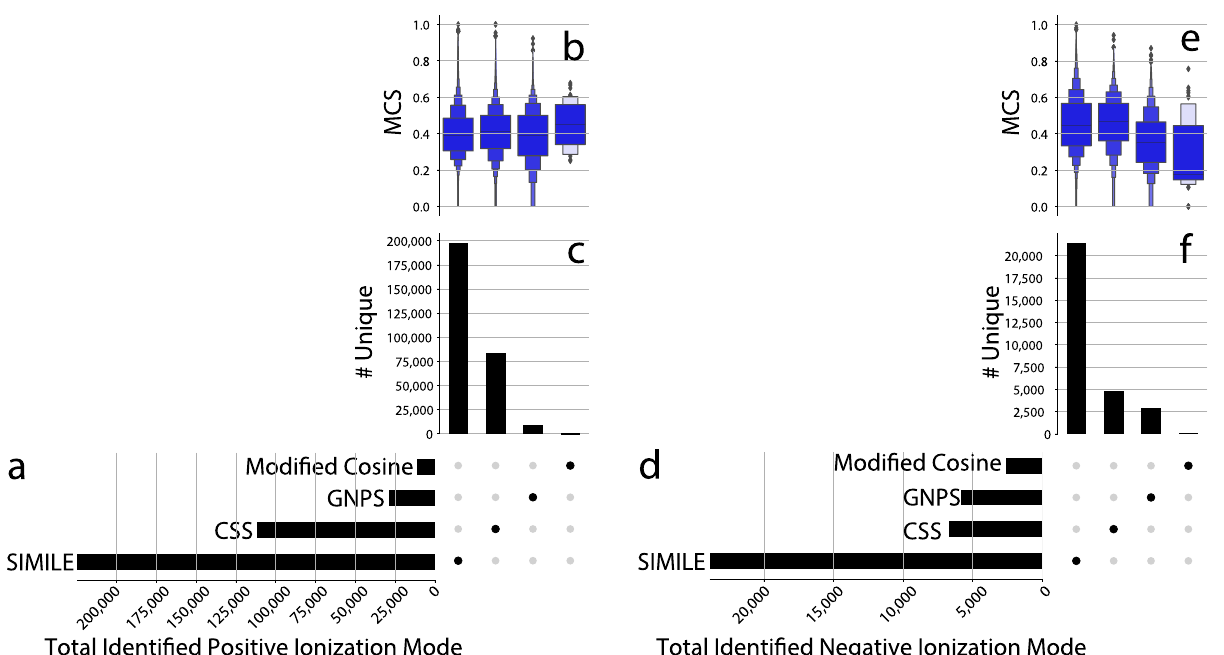
Fig. 4 SIMILE identi fi es the largest number of similar pairs and 88% and 89% of the pairs of spectra identi fi ed by SIMILE in positive and negative ionization mode were not found by any other algorithm. Pairs of spectra identi fi ed by each algorithm for positive ( a – c ) and negative ( d – f ) ionization modes can be seen in these UpSet plots. The total number of pairs identi fi ed by each algorithm is shown in the bar chart to the left ( a and d ), and the unique pairs identi fi ed by each algorithm along with their corresponding structural similarity are shown in ( b , c ) and ( e , f ). Boxen plots ( b , e ) show several quantiles of the maximum common substructure (MCS) for each algorithm to approximate a distribution 38